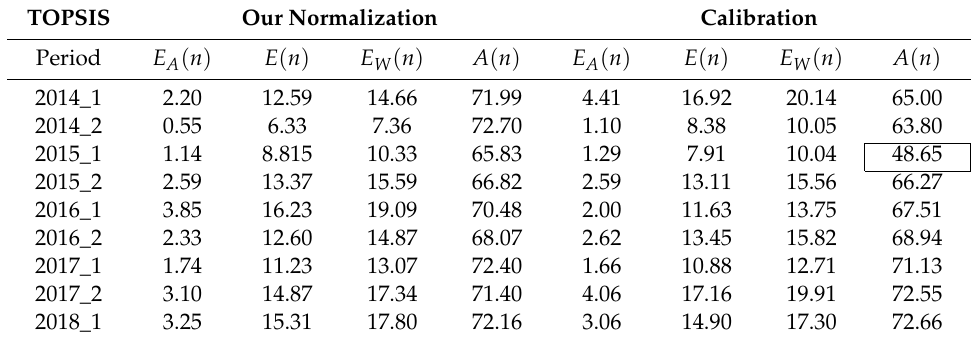
Table 7. Values of indicators obtained with TOPSIS method.